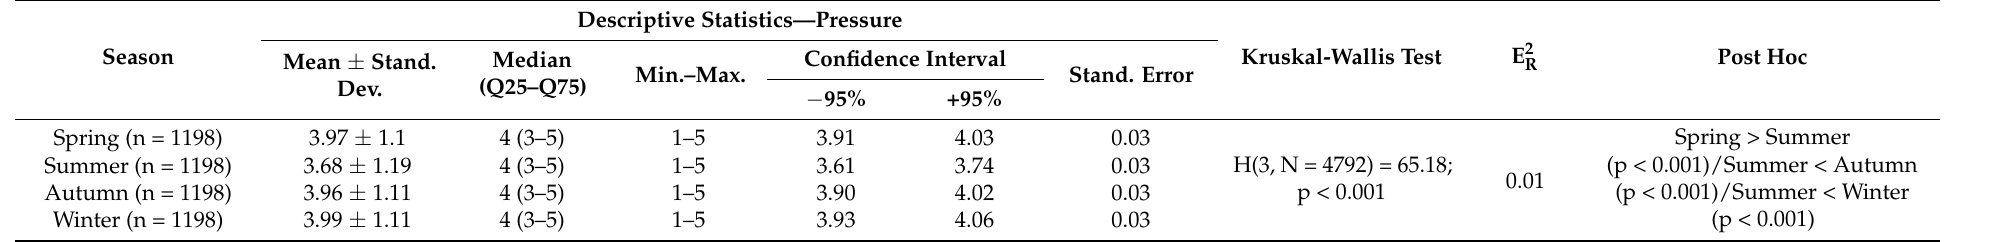
Table 3. Comparison of different seasons in terms of evaluation of tap water pressure